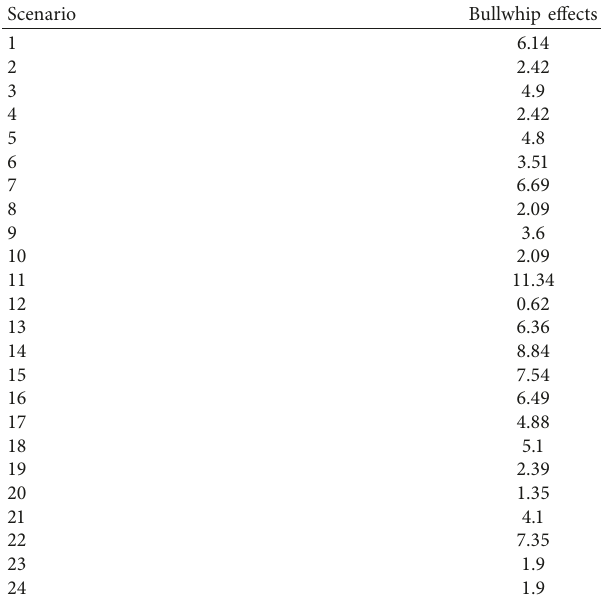
Table 8: Values of bullwhip effects for different forecasting